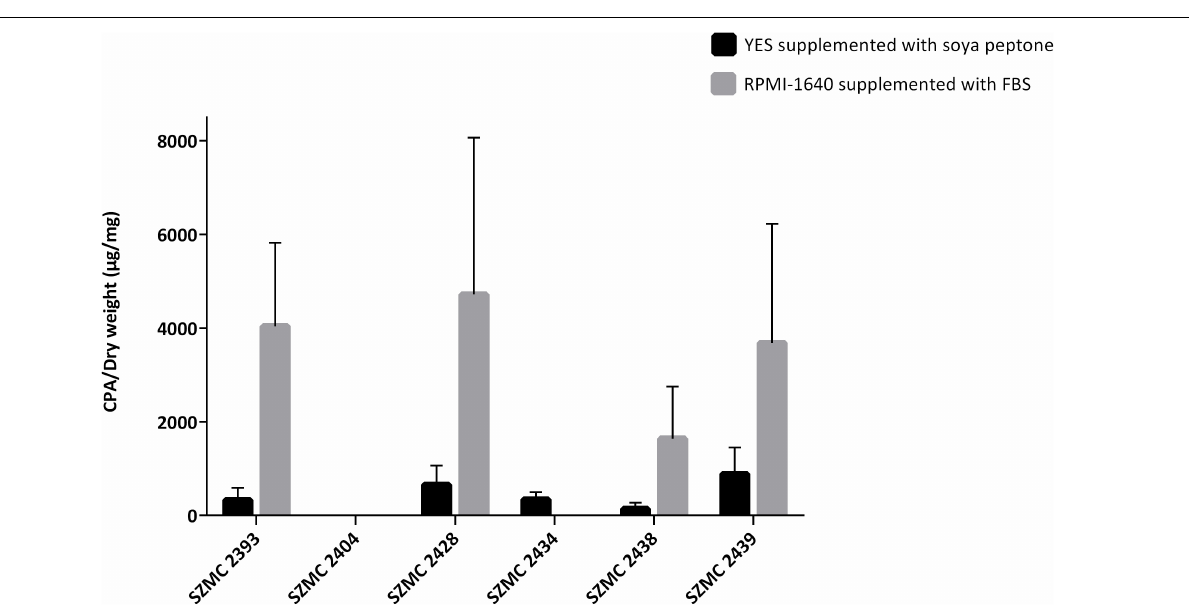
FIGURE 2 | Cyclopiazonic acid (CPA) producing ability ( µ g/mg mycelial dry weight) of the stationary cultures of A. tamarii isolates grown in yeast extract sucrose (YES) medium supplemented with soya peptone and in RPMI-1640 supplemented with fetal bovine serum (FBS) for 7 days in the dark. Results are the mean of two independent experiments with two individual replicates. The limit of quantitation was 500